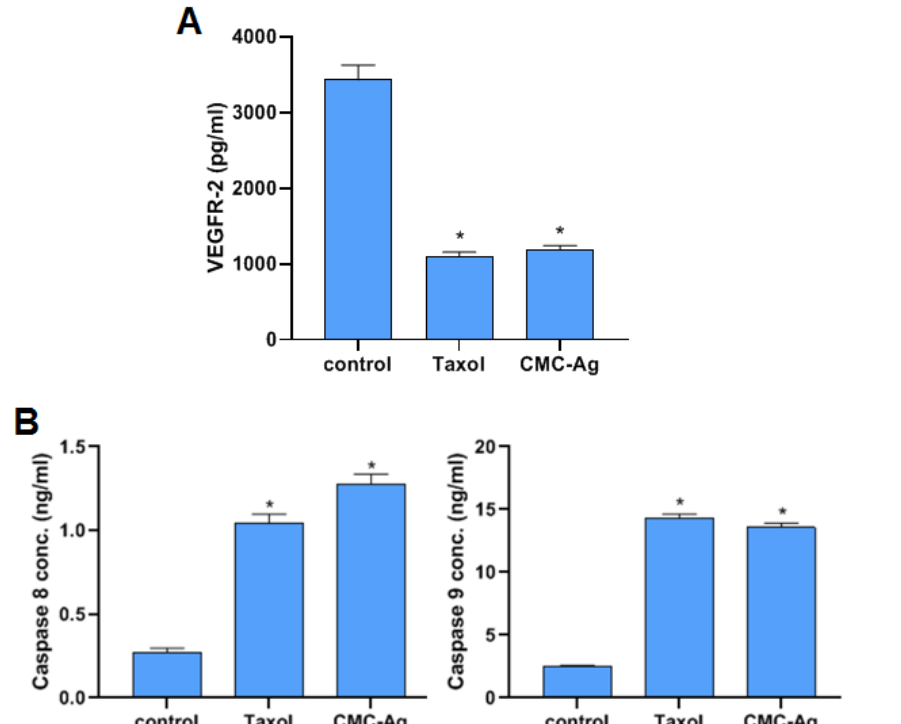
Figure 5. Effect of CMC-AgNPs on VEGFR-2 (pg/mL) in HepG2 cells compared to taxol ( A ); effect of CMC-AgNPs on caspase-8 and caspase-9 (ng/mL) in HepG2 cells compared to taxol ( B ). The results are shown as the mean ± SD. * Significantly different from the control (HepG2 cells) group at p < 0.0001.